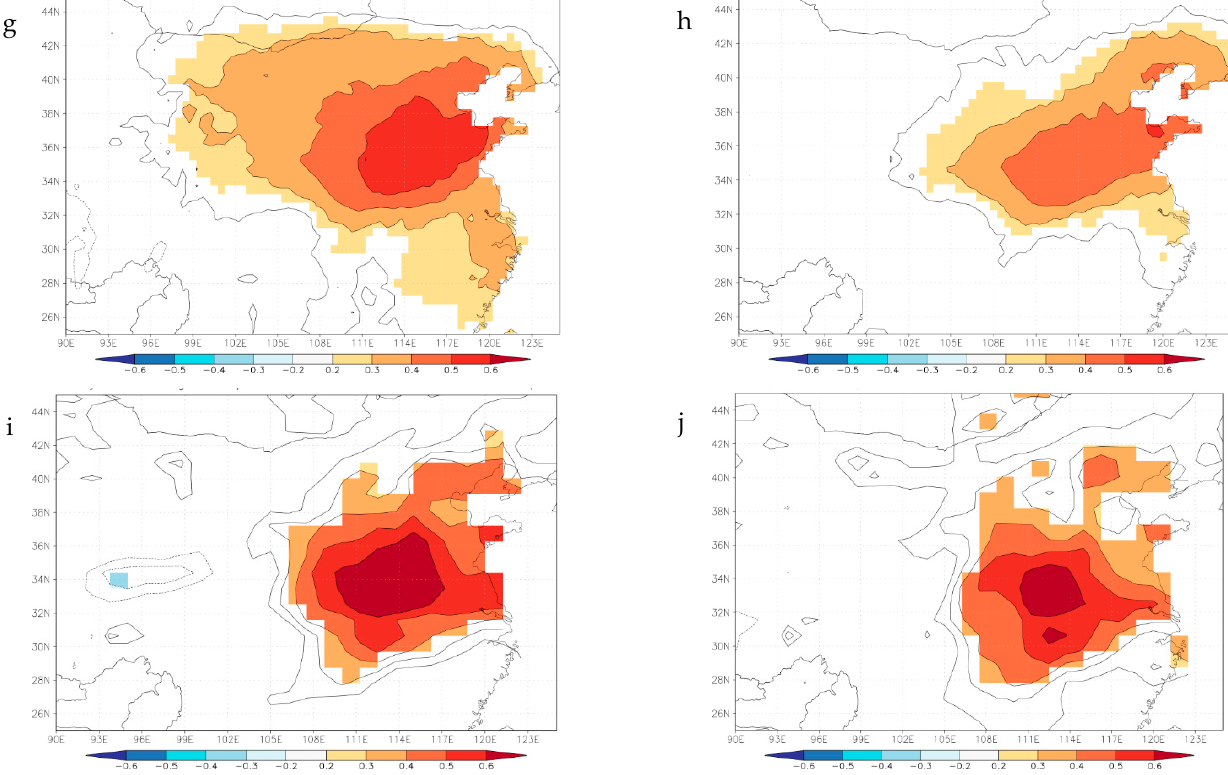
Figure 10. Spatial (90 ° -126 ° E, 25 ° -45 ° N) correlation analyses between actual (left) and reconstructed scPDSI MJ (right). ( a , b ) temperature, ( c , d ) precipitation, ( e , f ) potential evaporation, ( g , h ) vapor pressure (CRU TS4.04, 1963 – 2016), and ( i , j ) soil moisture (1979 – 2016, CLM/EARi, 0 – 10 cm).